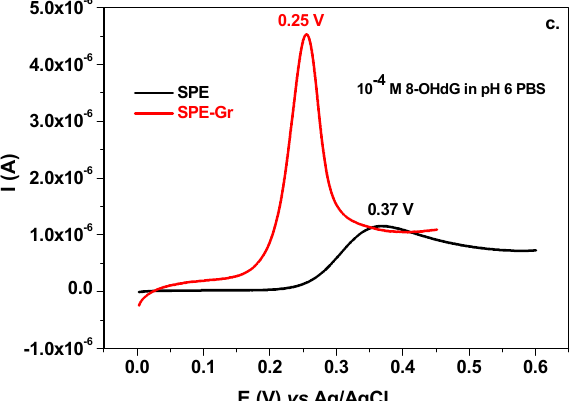
Figure 8. LSVs recorded with SPE ( a ) and SPE-Gr ( b ) in pH 6 PBS solutions containing various concentrations of 8-OHdG (1 × 10 − 7 –1 × 10 − 4 M); comparison between the SPE and SPE-Gr signals at one selected 8-OHdG concentration (1 × 10 − 4 M in pH 6 PBS) ( c ); 10 mV / s scan rate.